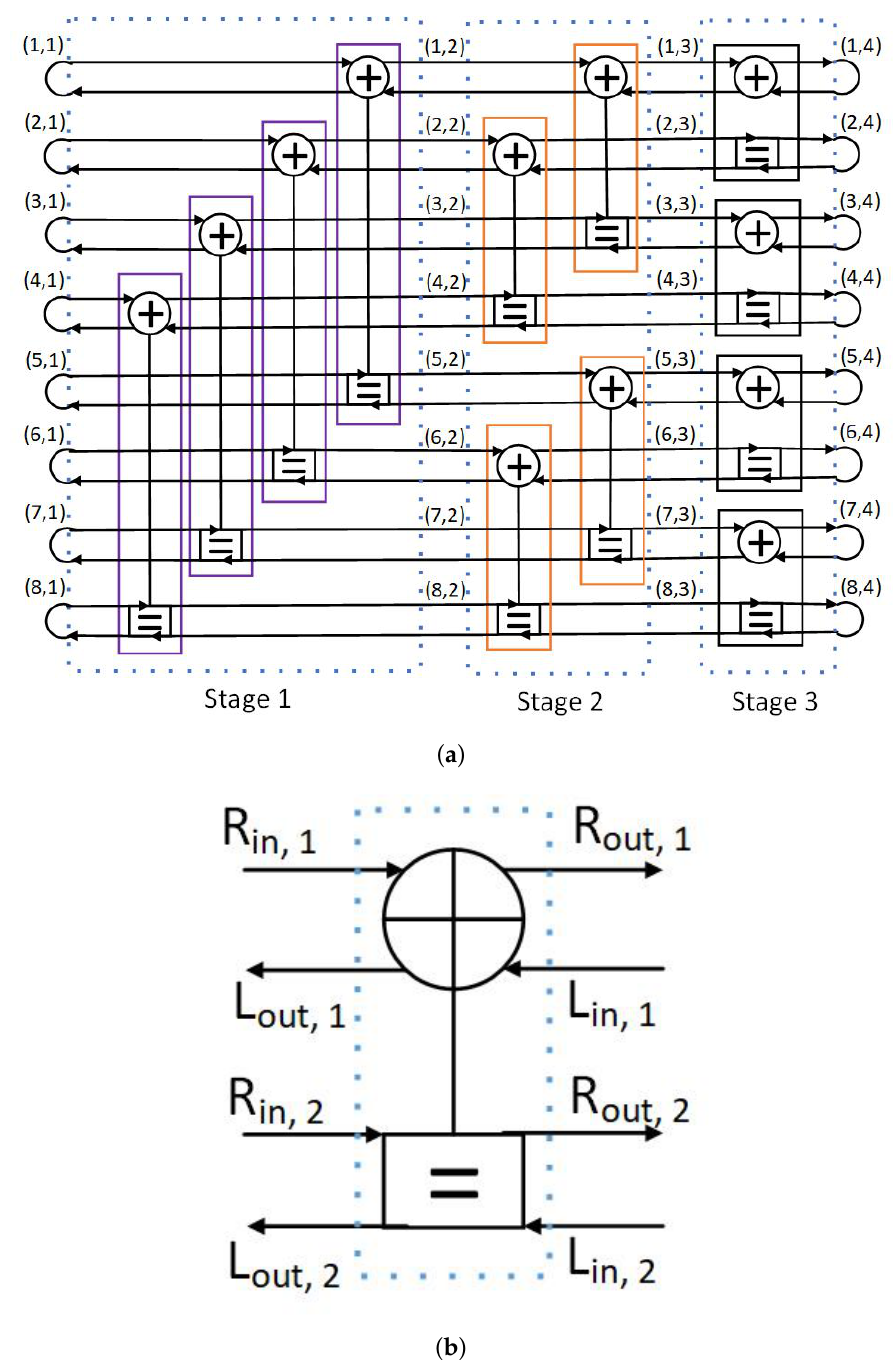
Figure 1. ( a ) Factor graph of P ( 8,4 ) polar codes. ( b ) A single processing element (PE) of belief propagation (BP) decoding highlighting the left-to-right and right-to-left